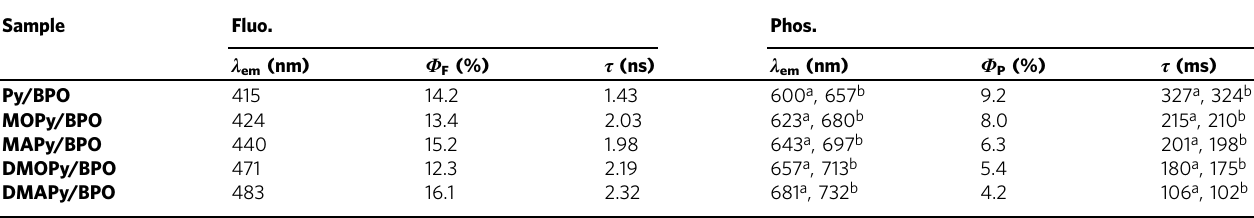
Table 1 Photophysical data of the guest – host